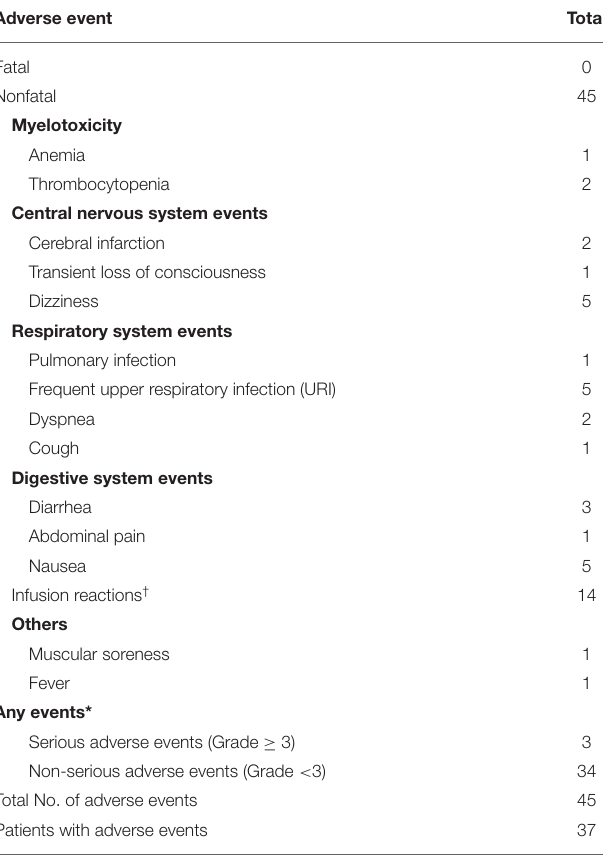
TABLE 6 | Adverse events in all patients with pMN receiving rituximab. Adverse